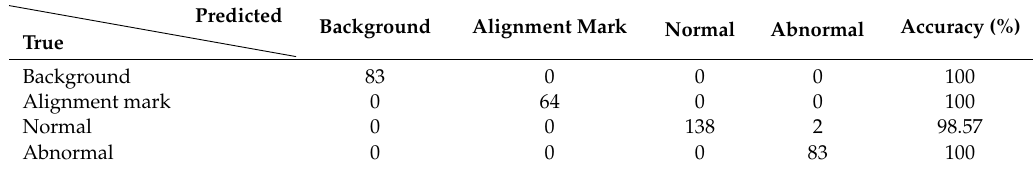
Figure 15. Training and validation accuracy. Table 5. Confusion matrix for additional 370 test Table 4. Data distribution in Dataset-I.